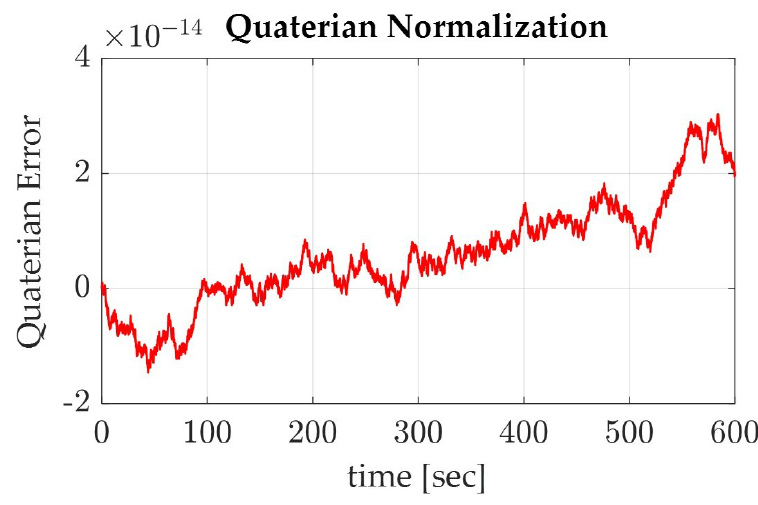
Figure 10. Graph of the normalized quaternions for the spacecraft on Pontryagin’s